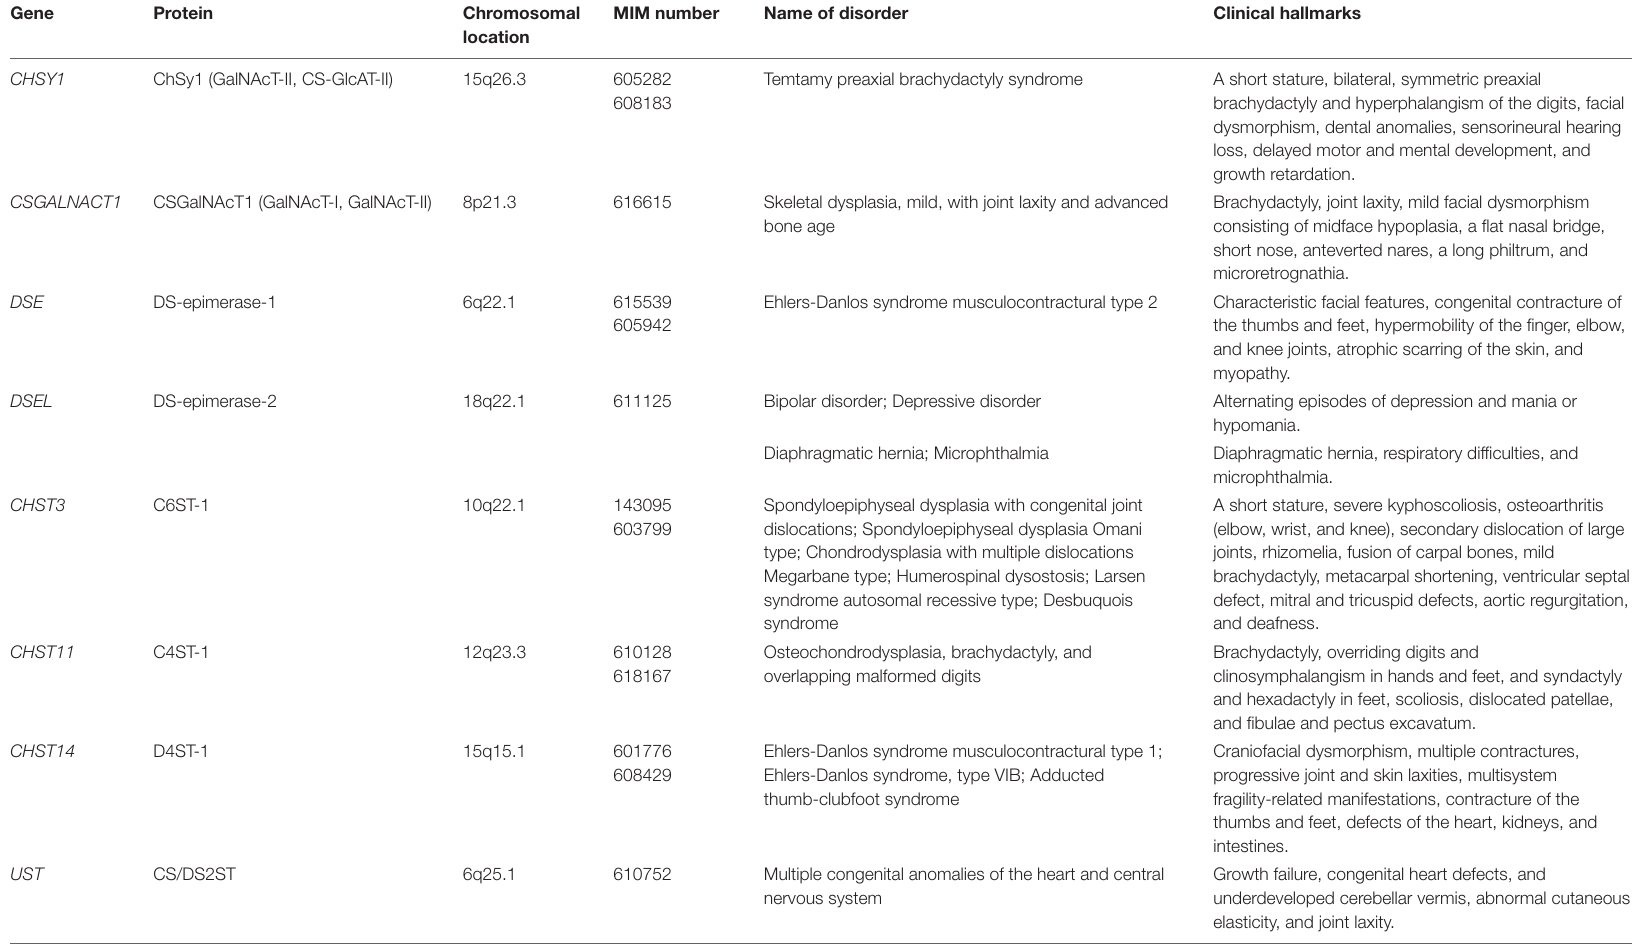
TABLE 2 | Congenital disorders of CS and DS